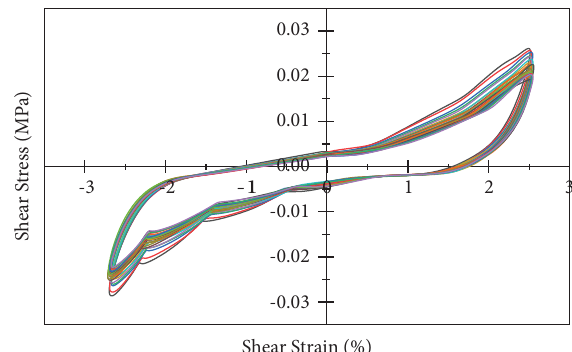
Figure 8: Hysteresis loops of P @ 3m of soil under 150kPa axial pressure and 5% cyclic shear strain of 40 cycles.